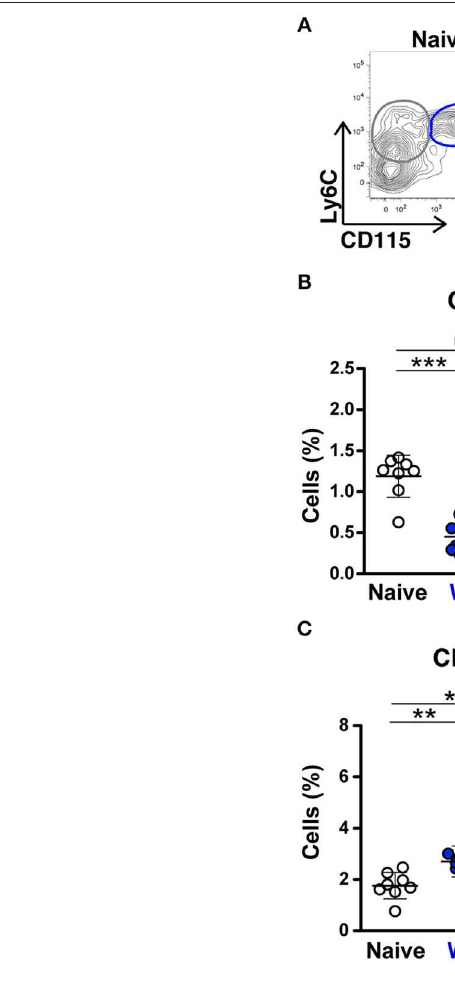
FIGURE 6 | Reduced CD115 expressions on splenic Ly6C + CD11b + monocytes in mice infected with WT sporozoites during the development of ECM. (A) Representative contour plots showing gating of Ly6C vs. CD115 expression on CD45 + Ly6G − CD11b + myeloid cells from naïve mice (left), and mice infected with WT (center) and PRF (right) sporozoites 8 days after infection. An arrow indicates the disappearance of CD115 + Ly6C + monocytes (blue circles) in spleens of mice infected with WT sporozoites. CD115 − Ly6C + monocytes are gated in gray circles. (B) Quantification of splenic CD115 + Ly6C + monocytes. Shown are percentage and numbers of CD115 + Ly6C + monocytes in the spleen. (C) Quantification of splenic CD115 − Ly6C + cells. Shown are percentage and numbers of CD115 − Ly6C + myeloid cells in the spleen. The scatter dot plots in (B,C) represent mean values ( ± SD) from samples ( n = 8–11) isolated 8 days after infection from two independent experiments. n.s, non-significant; * P < 0.05; ** P < 0.01; *** P < 0.001 (Mann-Whitney